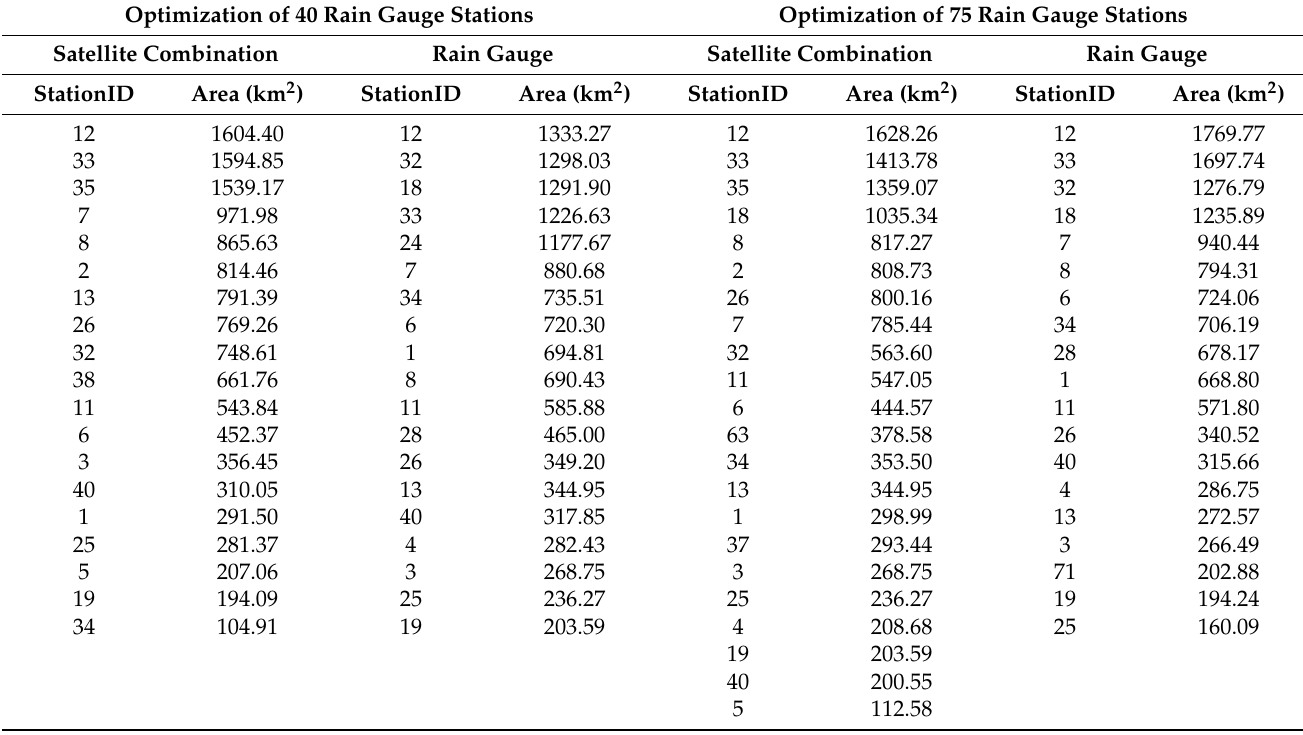
Table 3. Comparison of station coverage area under the optimization of 40 and 75